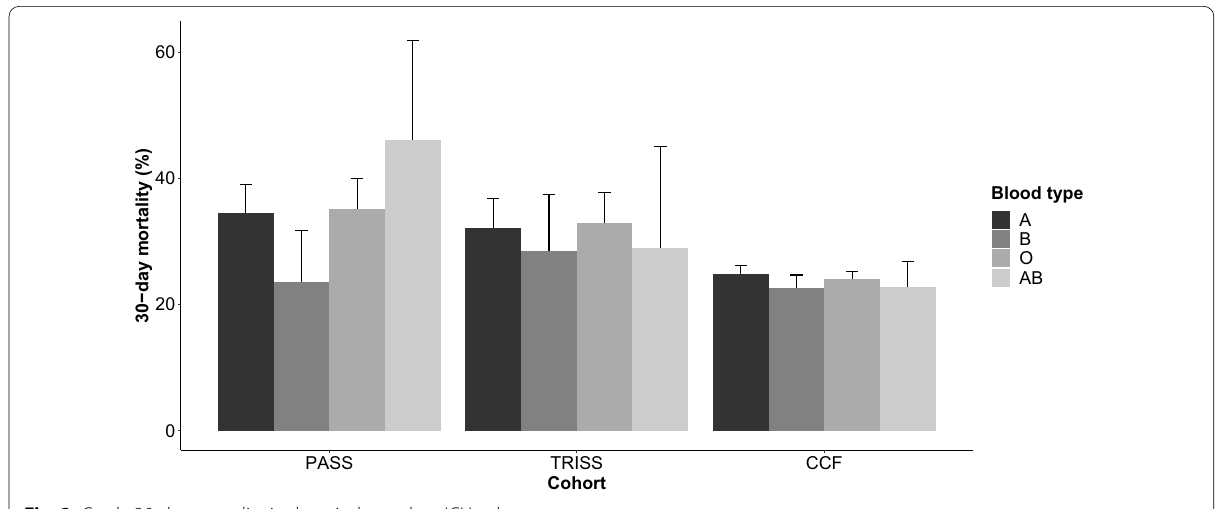
a All cohorts adjusted for age, sex, ischemic heart disease, previous stroke and whether the patient had a pulmonary infection focus